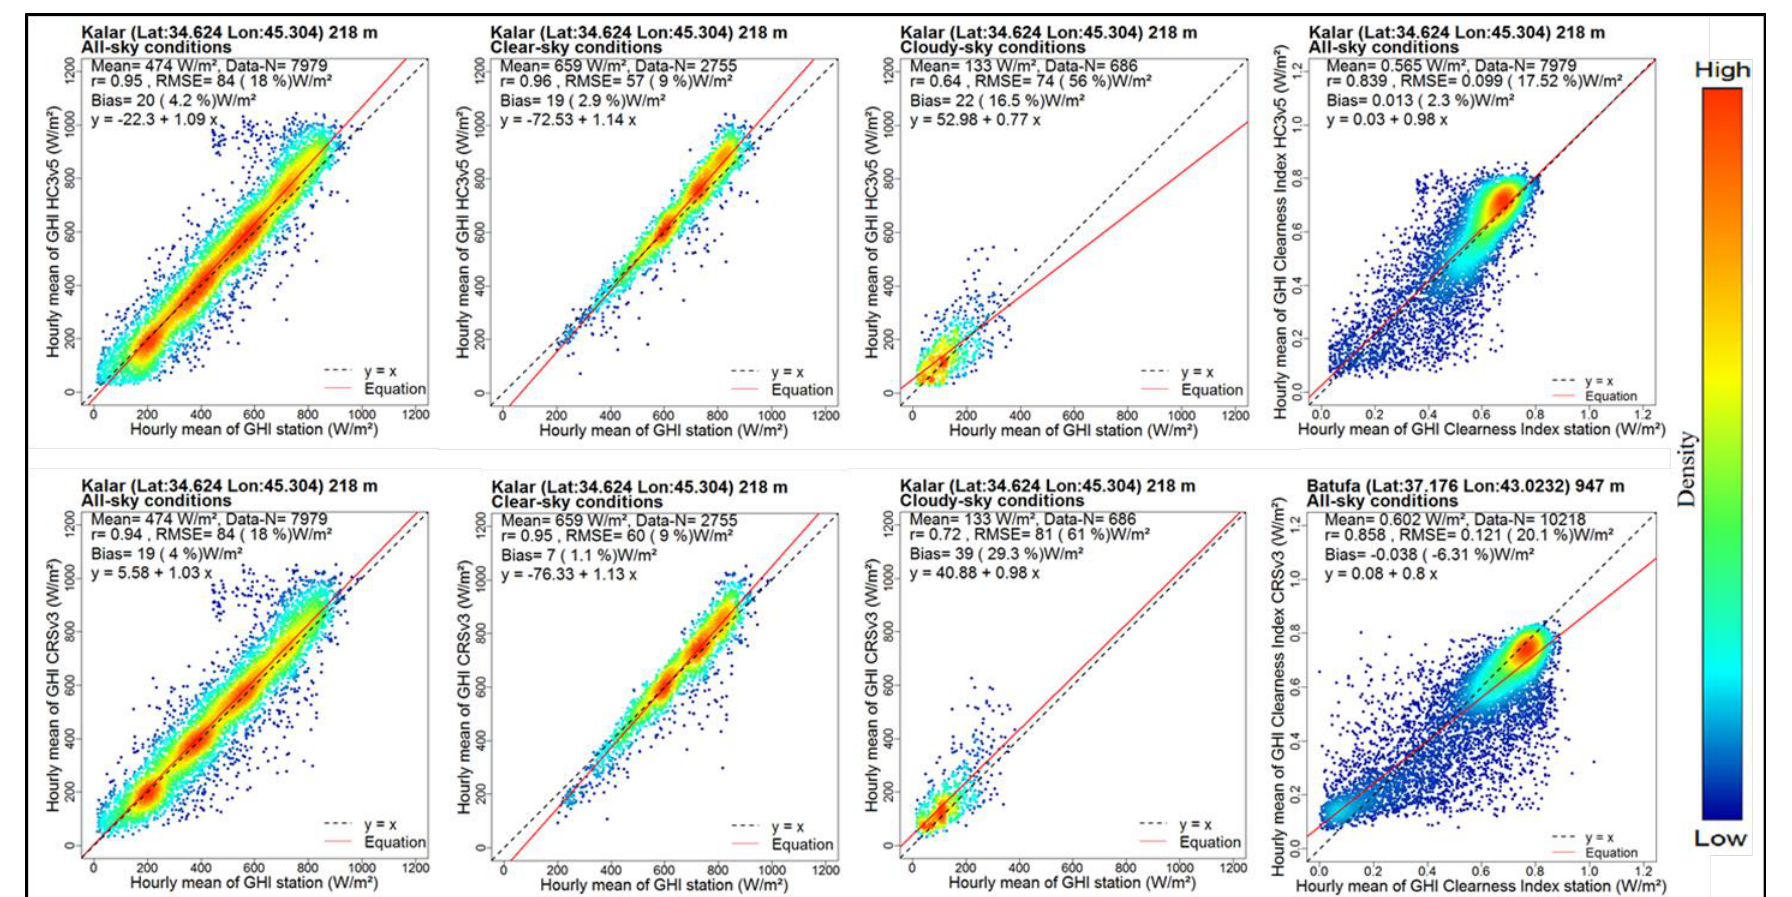
Figure 10. Scatter plot between hourly GHI ground measurements and SDDs (HC3v5 and CRSv3) for Kalar station for all-sky, clear-sky and cloudy-sky conditions and the clearness index.